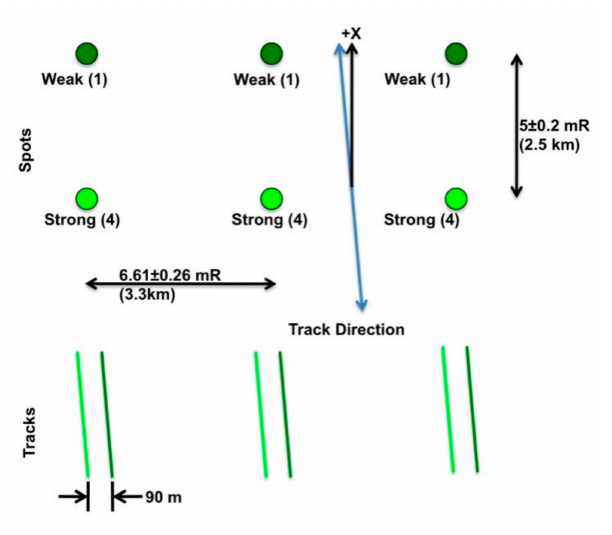
Figure 2. Schematic diagram of the track of ICESat-2 (https://icesat-2.gsfc.nasa.gov/science/specs, accessed on 14 December